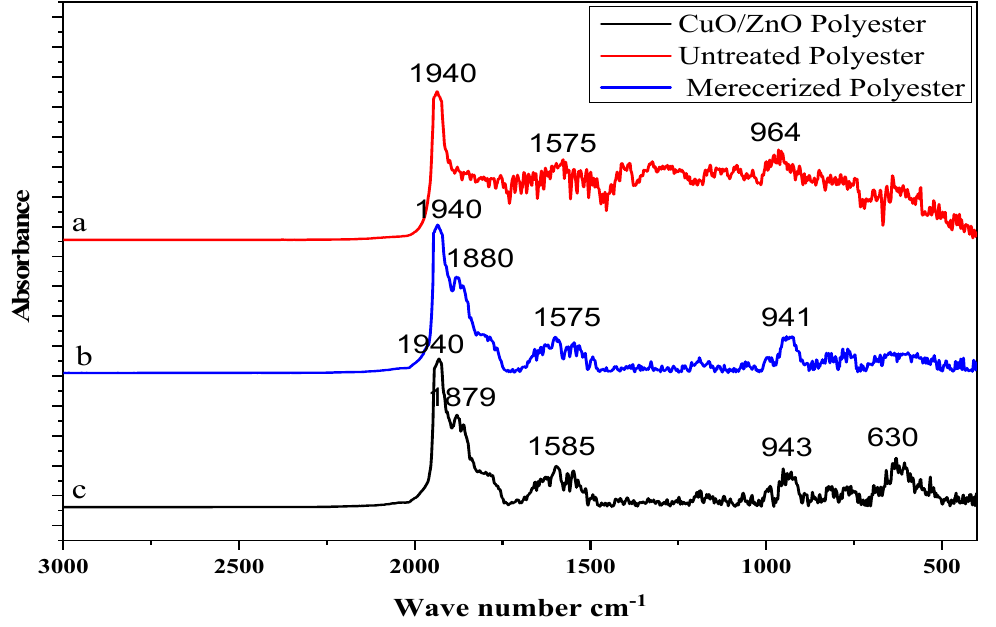
Figure 5. FTIR spectra of ( a ) untreated polyester, ( b ) mercerized polyester, and ( c ) ZnO/CuO/PF PMR. Table 1. Experimental results of solar photocatalytic reduction of Cr(VI) for runs provided by central composite